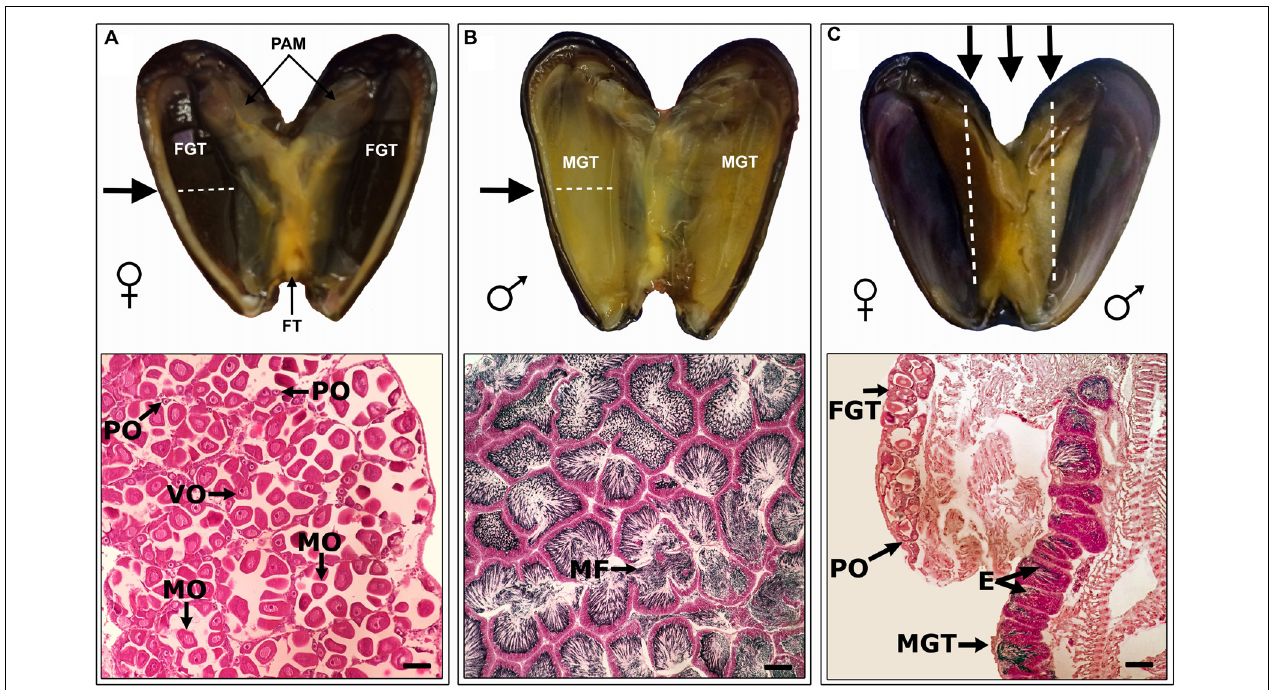
FIGURE 1 | Examples of Semimytilus algosus mantle tissue coloration. Transverse section showing detail of ( A – top panel) female and ( B – top panel) male follicle in the mantle lobe. Longitudinal section ( C – top panel) showing the details of an hermaphroditic individual. The arrows indicate the direction of the histological section. Bottom panels A-C show micrographs of histological sections (haematoxylin-eosin staining) of S. algosus , for a female, male and an hermaphrodite. FGT: Female Gonadal Tissue, MGT: Male Gonadal Tissue, MF: Male follicle, PO: Previtellogenic oocyte, VO: Vitellogenic oocyte, MO: Mature oocyte, and E: spermatozoa in the lumen, FT: Foot and PAM: Posterior Adductor Muscle. Scale bar (bottom right of each lower panel): A and B = 100 µ m, C = 500 µ m.